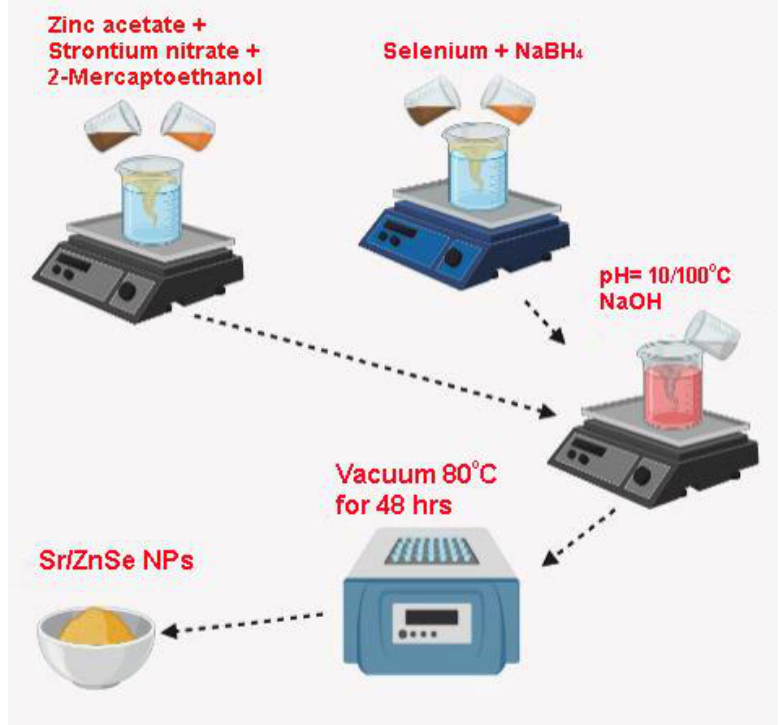
Figure 1. Synthesis process of the Sr-doped ZnSe